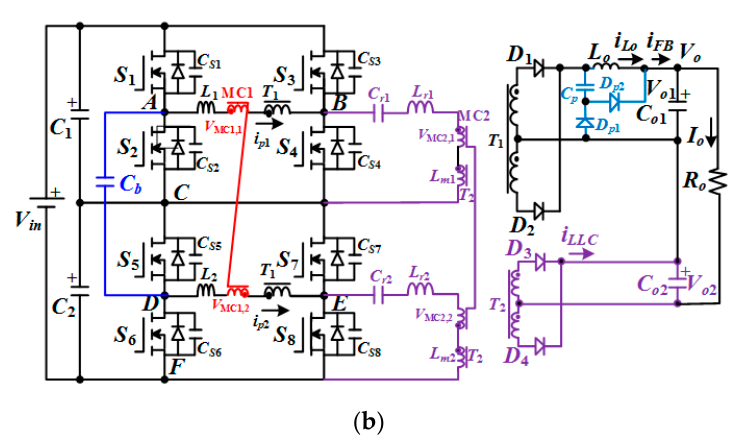
Figure 2. Proposed converter ( a ) circuit configuration with current balance ( b ) circuit diagram with low freewheeling current, current and voltage balance and wide ZVS operation.